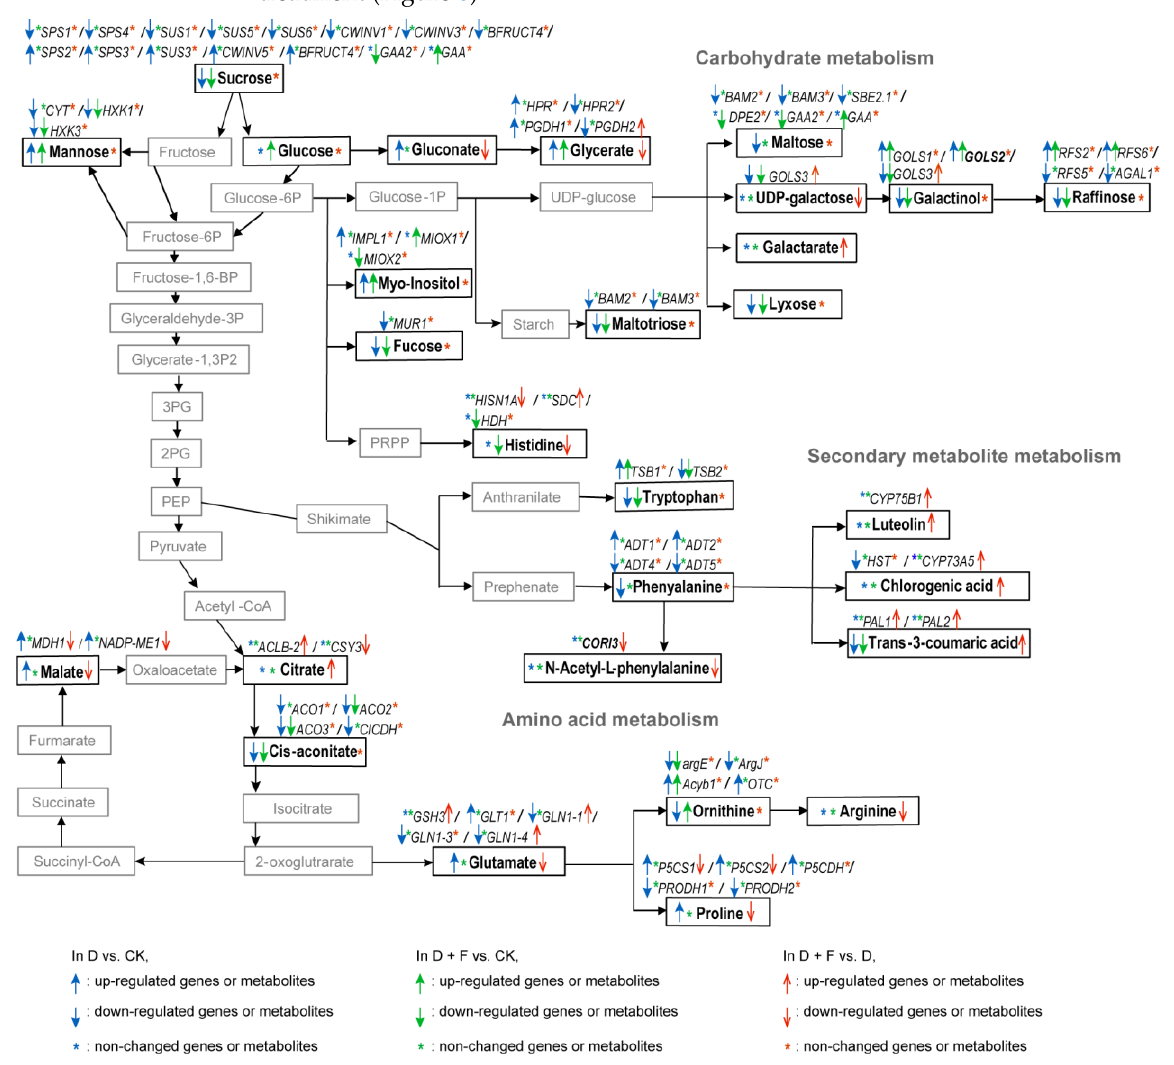
Figure 6. Map of genes and metabolites enriched in common KEGG pathways related to carbohydrate metabolism, amino acid metabolism, and biosynthesis of plant secondary metabolites in a comparison between drought (D) and check (CK, sufficient water condition), between drought with fullerol treatment (D + F) and check (CK), or between drought with fullerol treatment (D + F) and drought alone (D). Downward-pointing arrows indicate that the genes or metabolites are down-regulated, and upward-pointing arrows indicate that the genes or metabolites are up-regulated. The blue arrows indicate changes in genes or metabolites occurring in the D vs. CK group, the green arrows indicate changes in genes or metabolites occurring in the D + F vs. CK group, and the red arrows indicate changes occurring in the D + F vs. D group. The differentially expressed genes with assay names of the gene ID are given in Supplementary Materials File S10.